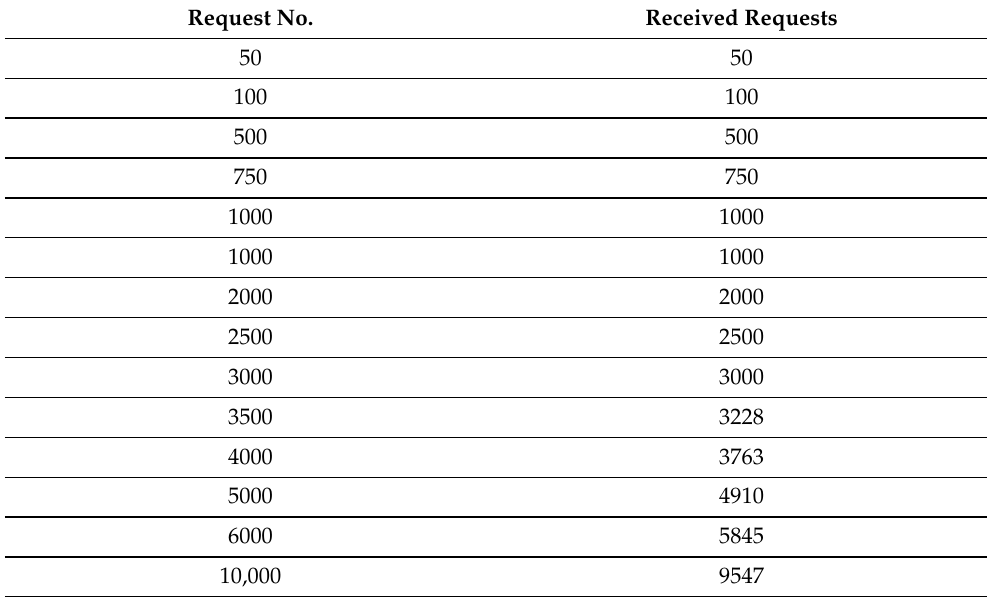
Table 7. Relation between sent and received messages on a local-virtualized platform. Request